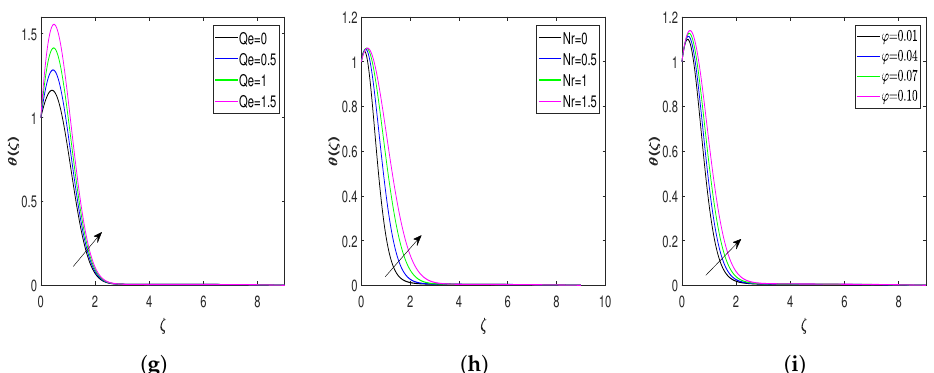
Figure 5. Nondimensional temperature profiles for different values of influential parameters. ( a ) Tem- perature profile against M ; ( b ) temperature profile against E 1 ; ( c ) temperature profile against Pr ; ( d ) temperature profile against Ec ; ( e ) temperature profile against Nt ; ( f ) temperature profile against Nb ; ( g ) temperature profile against Q e ; ( h ) temperature profile against Nr ; and ( i ) temperature profile against ϕ .